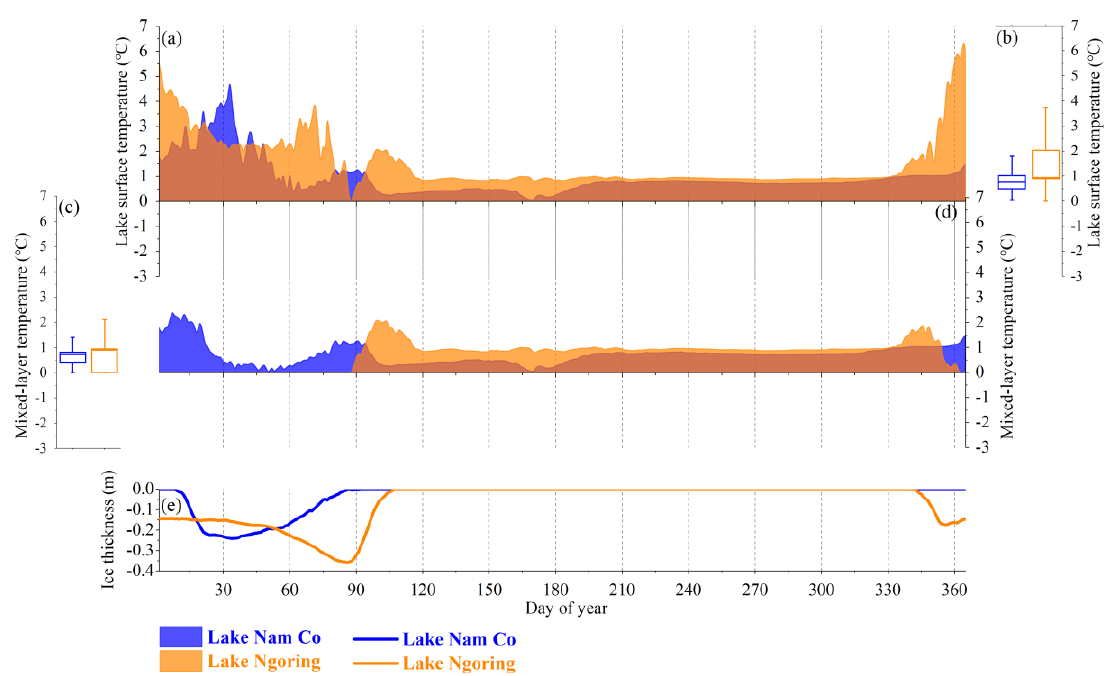
Figure 1 0 . Comparison of changes in the differences, when the air temperature rises by 0 °C and by 3.5 °C (the latter minus the former), for H, LE and ice thickness for Lake Nam Co and Lake Ngoring (averaged from January 2012 to December 2016): (a, b) LE, (c, d,) H, and (e) lake ice thickness.